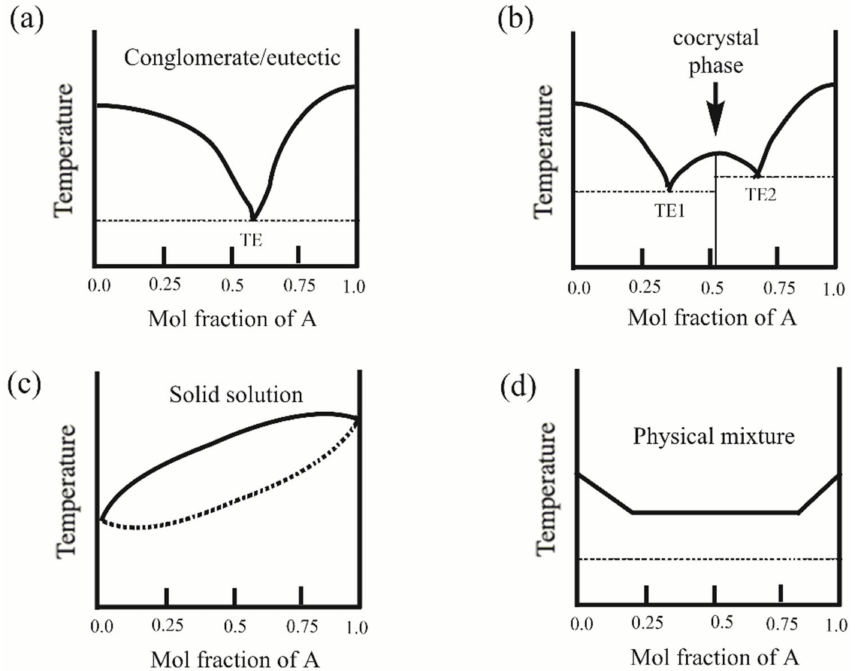
Figure 13. Schematic representation of binary phase diagrams (components A + B). ( a ) Solid eutectic mixture; TE: eutectic temperature. ( b ) Cocrystal formation; TE1 and TE2: eutectic temperatures 1 and 2. ( c ) Solid solution formation. ( d ) Physical mixture. Adapted with permission from [48], MDPI,